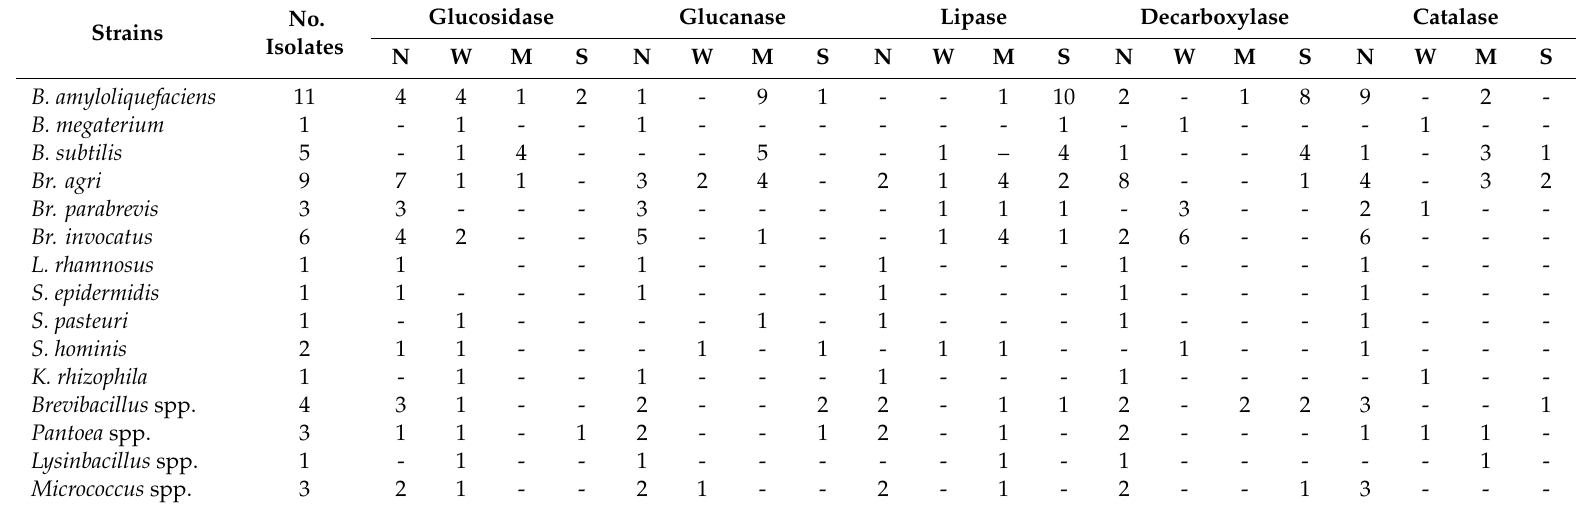
Table 2. Enzymatic activities of